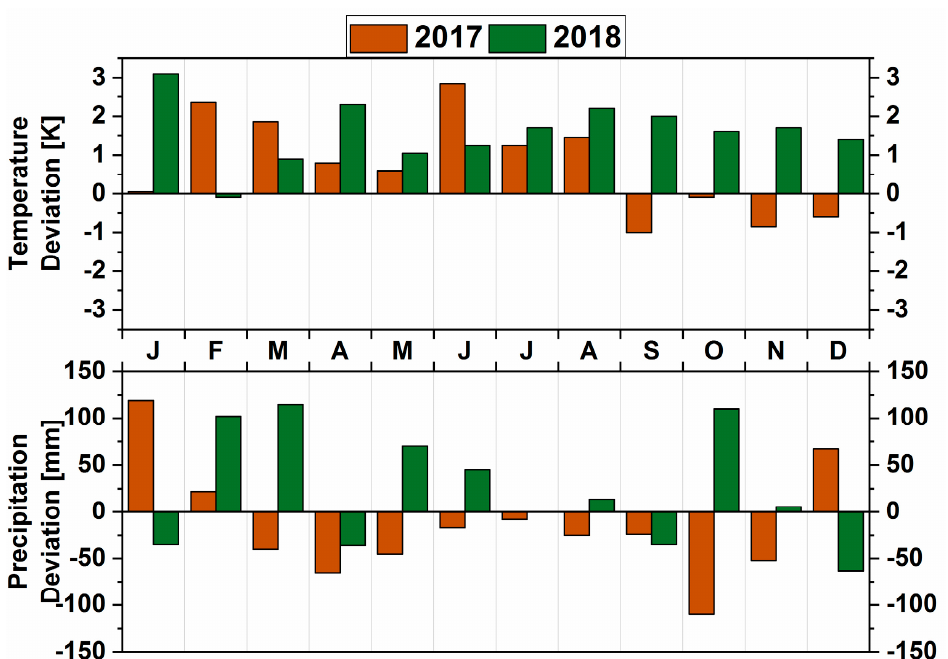
Figure 3. Temperature and precipitation deviations from the long-term monthly mean (1981–2010) in 2017 and 2018. Data was compiled from 11 climate stations at 5–1030 m asl across the whole geographical extent of Corsica [42].